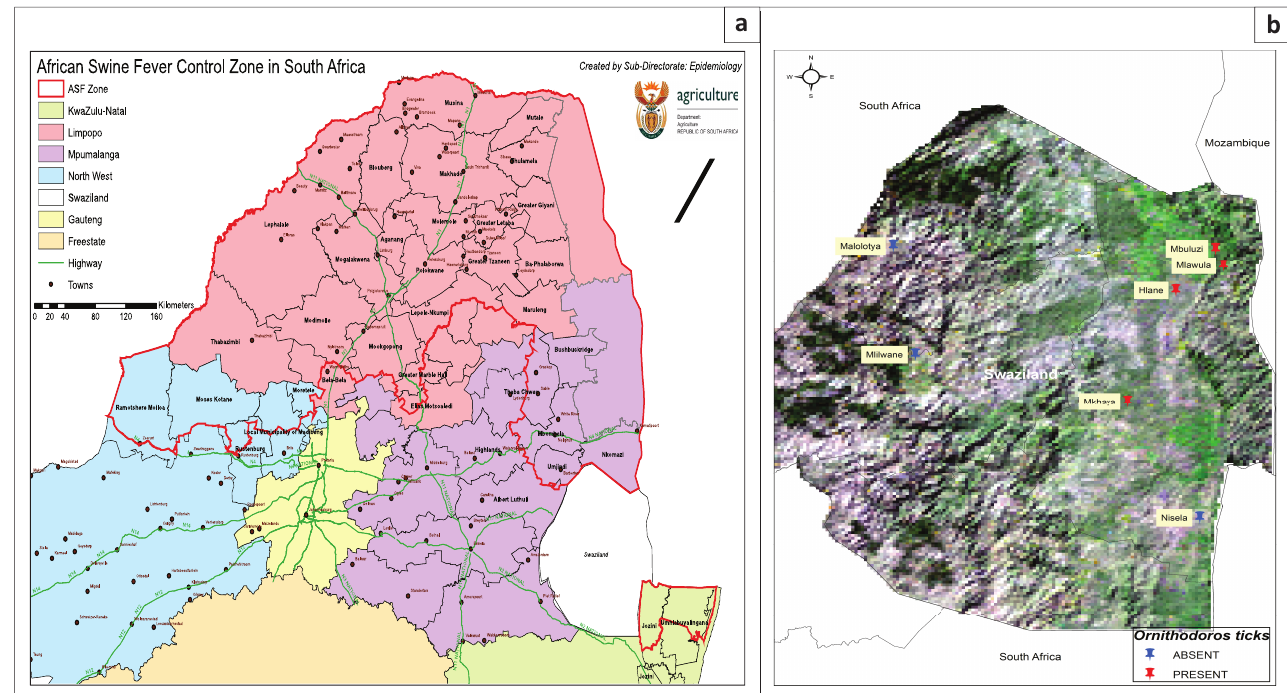
FIGURE 1: Map indicating (a) Swaziland surrounded by the African Swine Fever control zone (indicated in red) and (b) the topography of Swaziland, the game reserves sampled in this study and Ornithodoros tick presence or